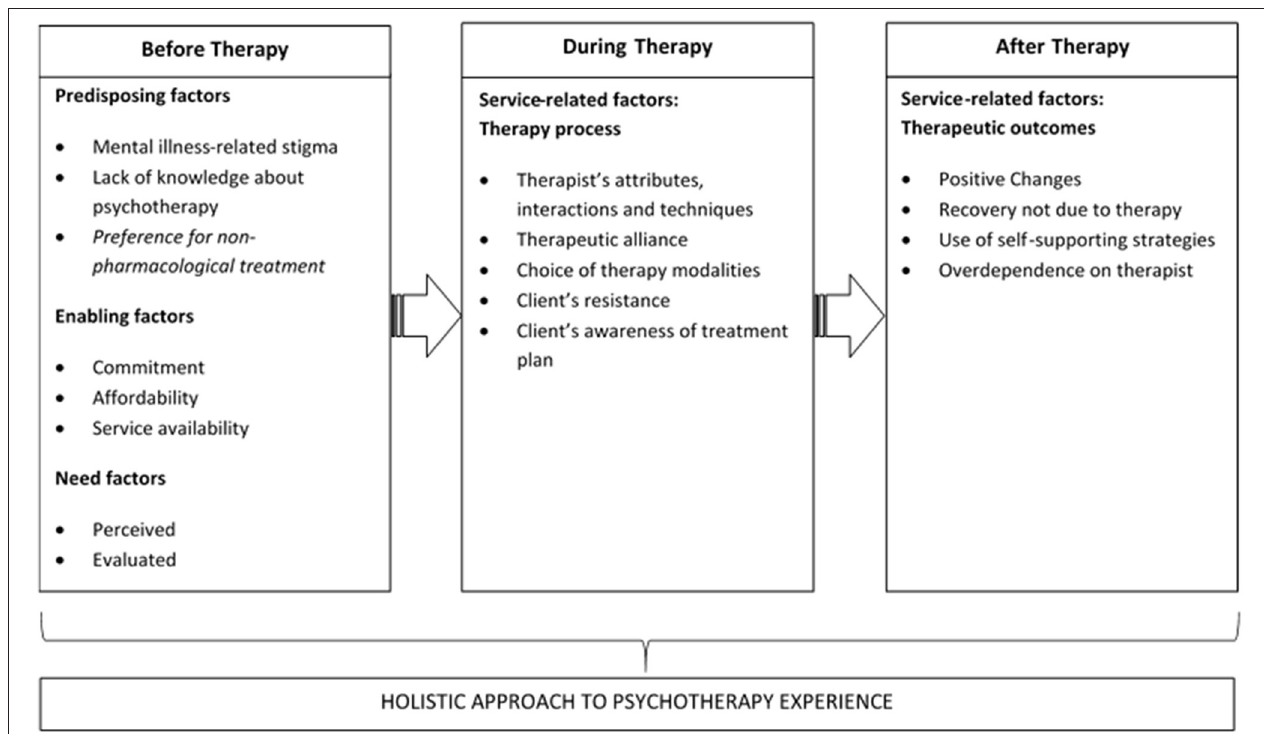
FIGURE 1 | Client experience with psychotherapy service